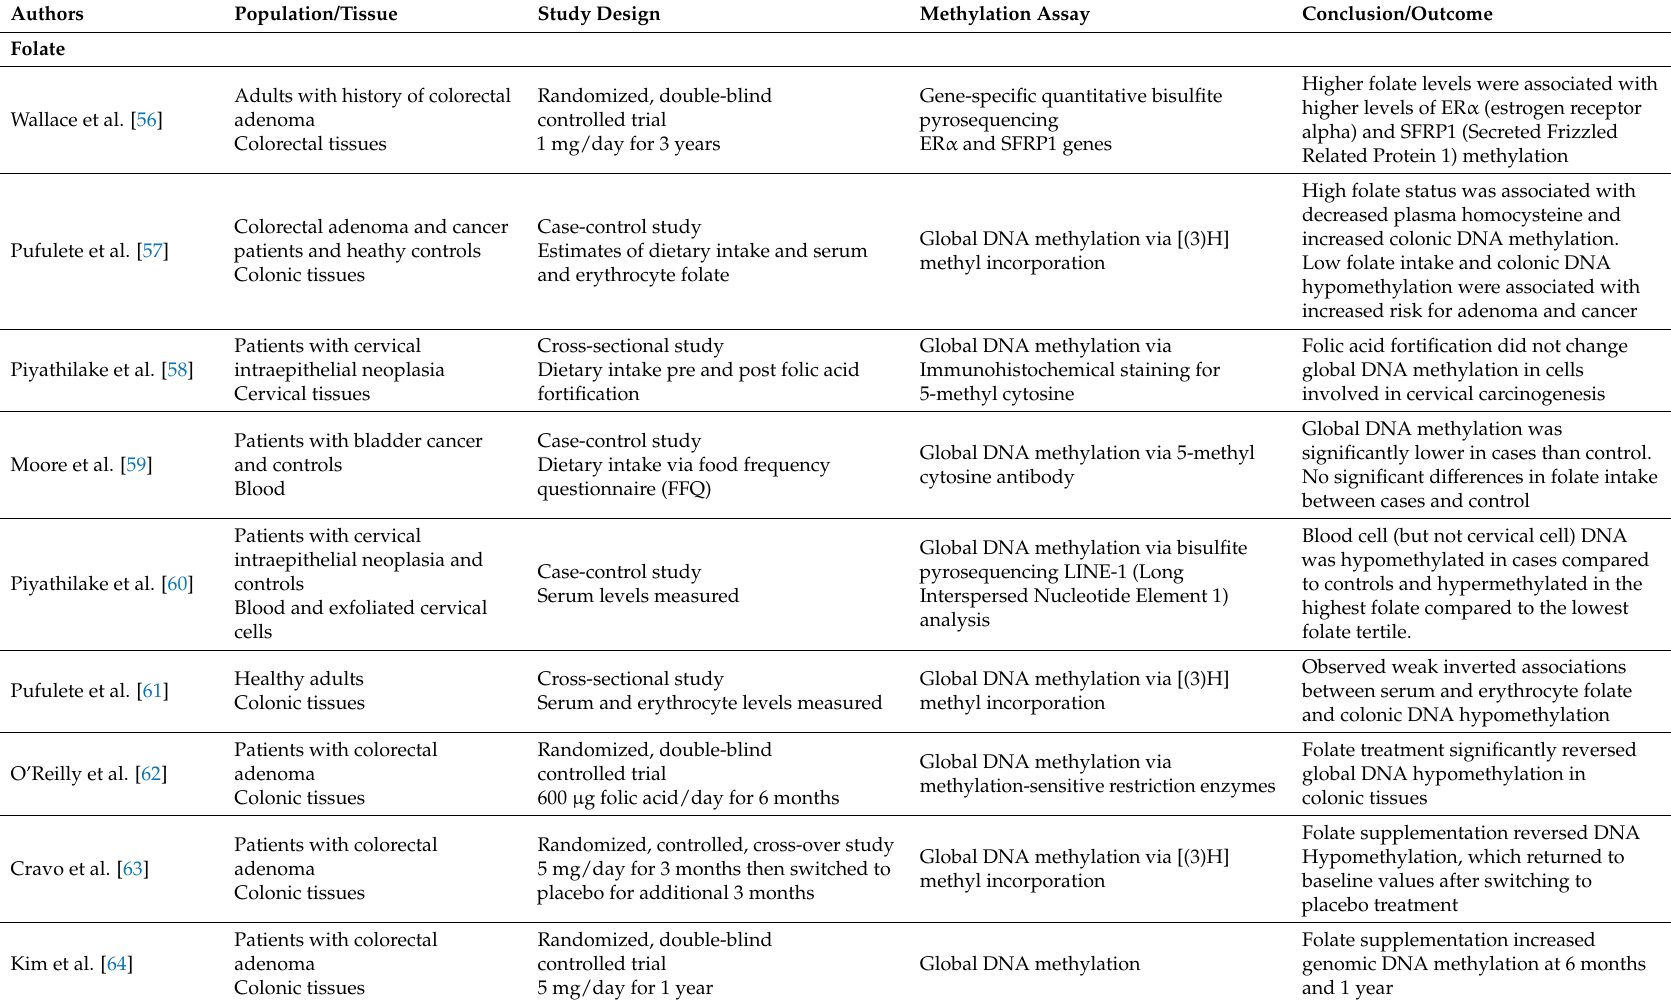
Table 1. Clinical studies of the impact of methyl donor micronutrients on DNA